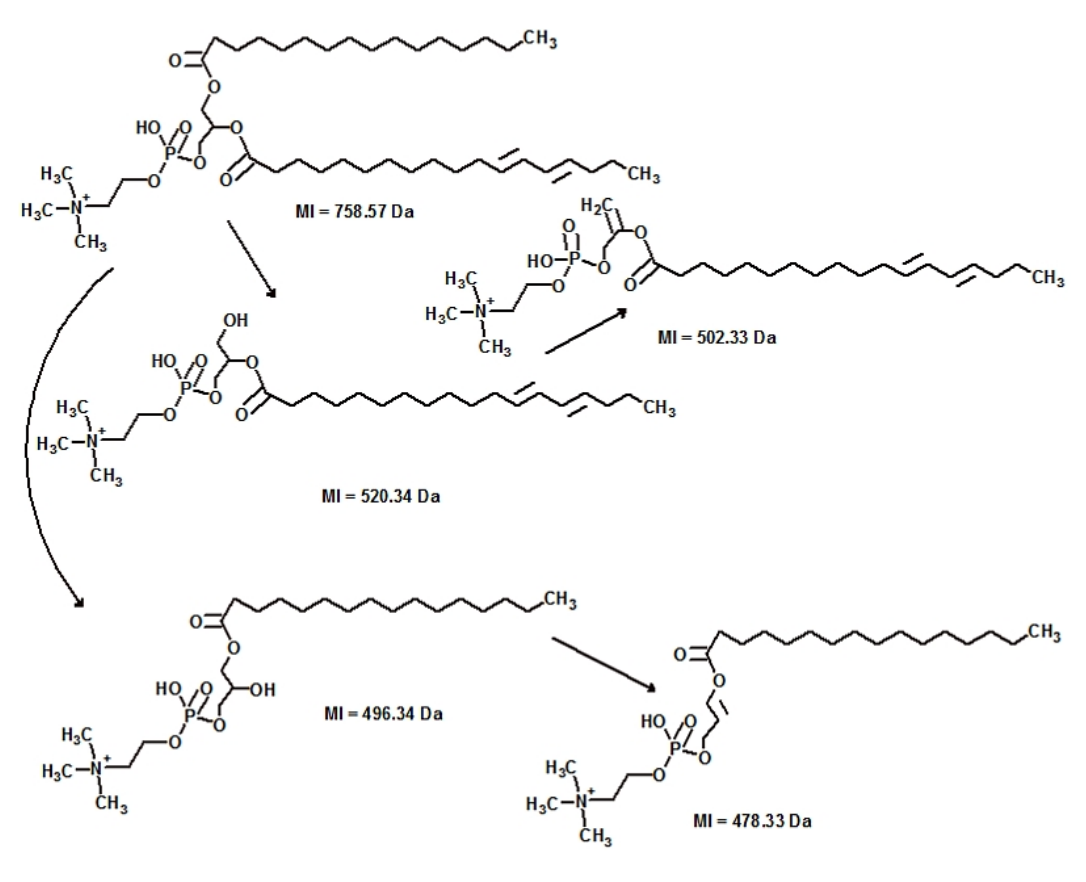
Figure 3. ESI-MS/MS fragmentation pattern typical for all observed isomers of polar lipid PC (34:2) found in this